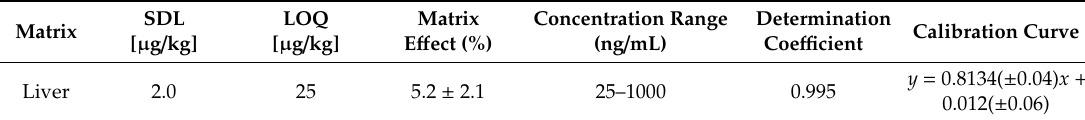
Table 1. Validation report for strychnine. SDL: screening detection limit.